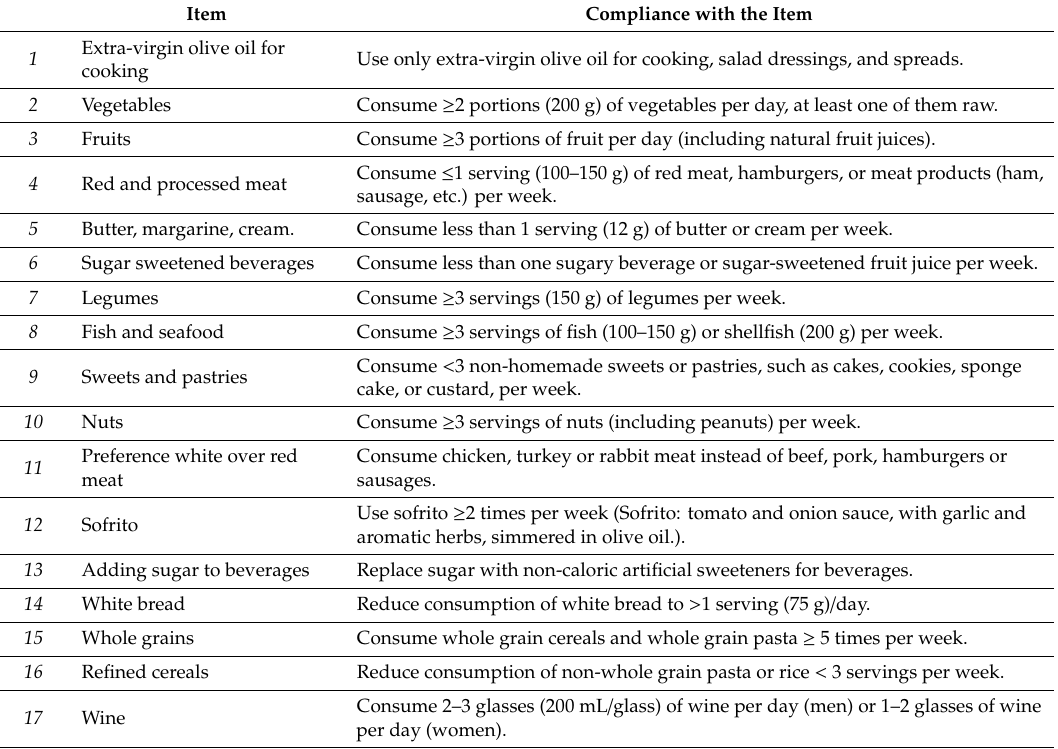
Table 1. Description of the 17-item Mediterranean dietary questionnaire. Compliance with the